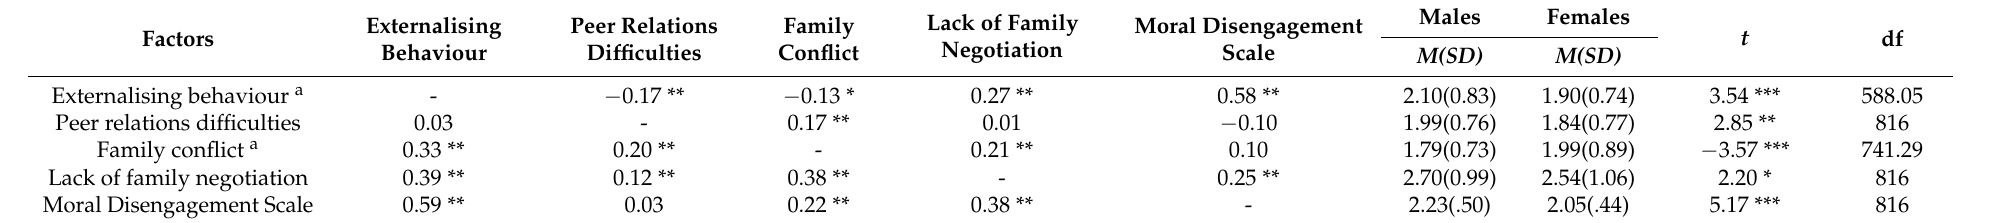
Table 2. Gender differences and correlations among the Family, Peers, and Externalising Behaviour (FPEB) factors and the Moral Disengagement